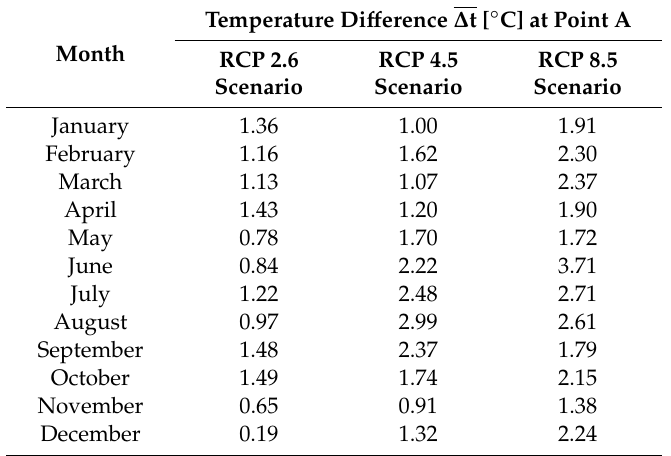
Table 5. Monthly temperature difference between future and historical scenarios.